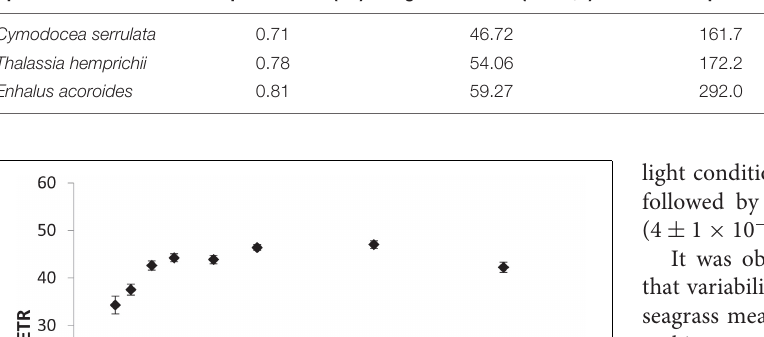
TABLE 2 | The absorption factor (AF), photosynthetic parameters derived from the rapid light curve and O 2 / ETR ratios under in situ light irradiance for three studied seagrass species Species